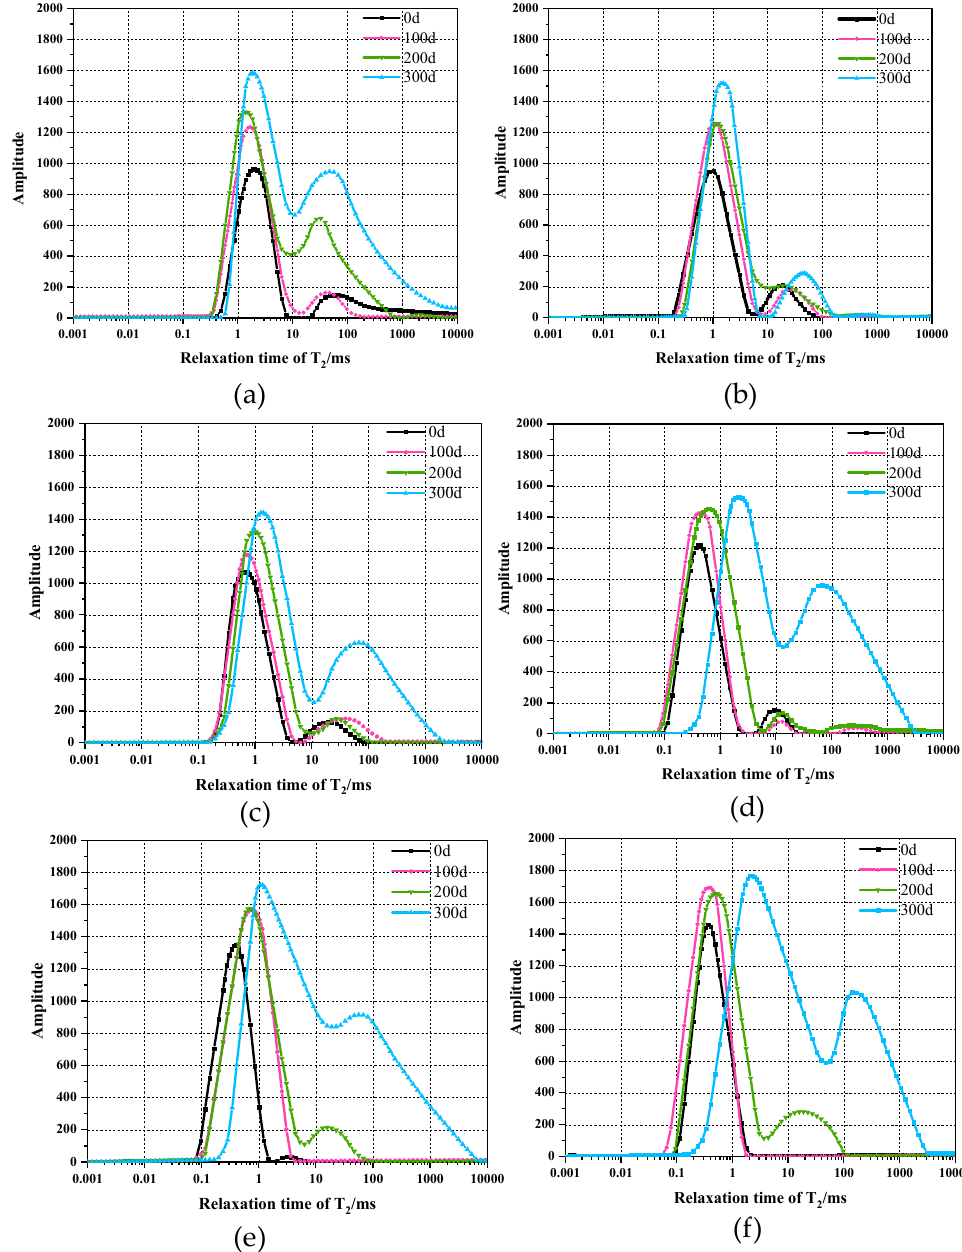
Figure 9. The T2 Spectrum and pore size distribution of HPC specimens subject to sulfate erosion: ( a ) 0% Nano-silica; ( b ) 1% Nano-silica; ( c ) 2% Nano-silica; ( d ) 3% Nano-silica; ( e ) 4% Nano-silica; ( f ) 5% Nano-silica.